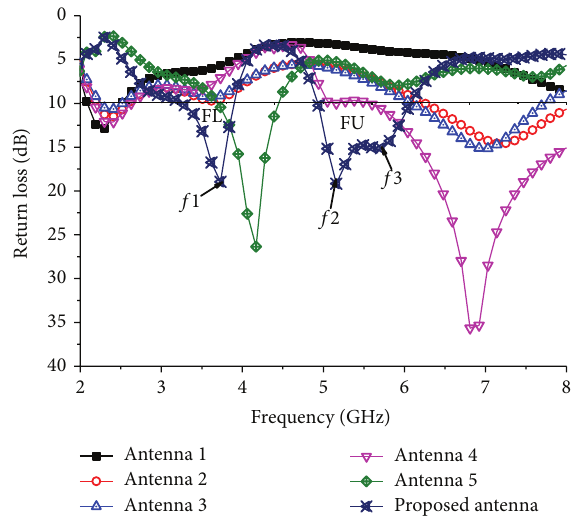
Figure 4: Simulated return loss of all prototype antennas and proposed